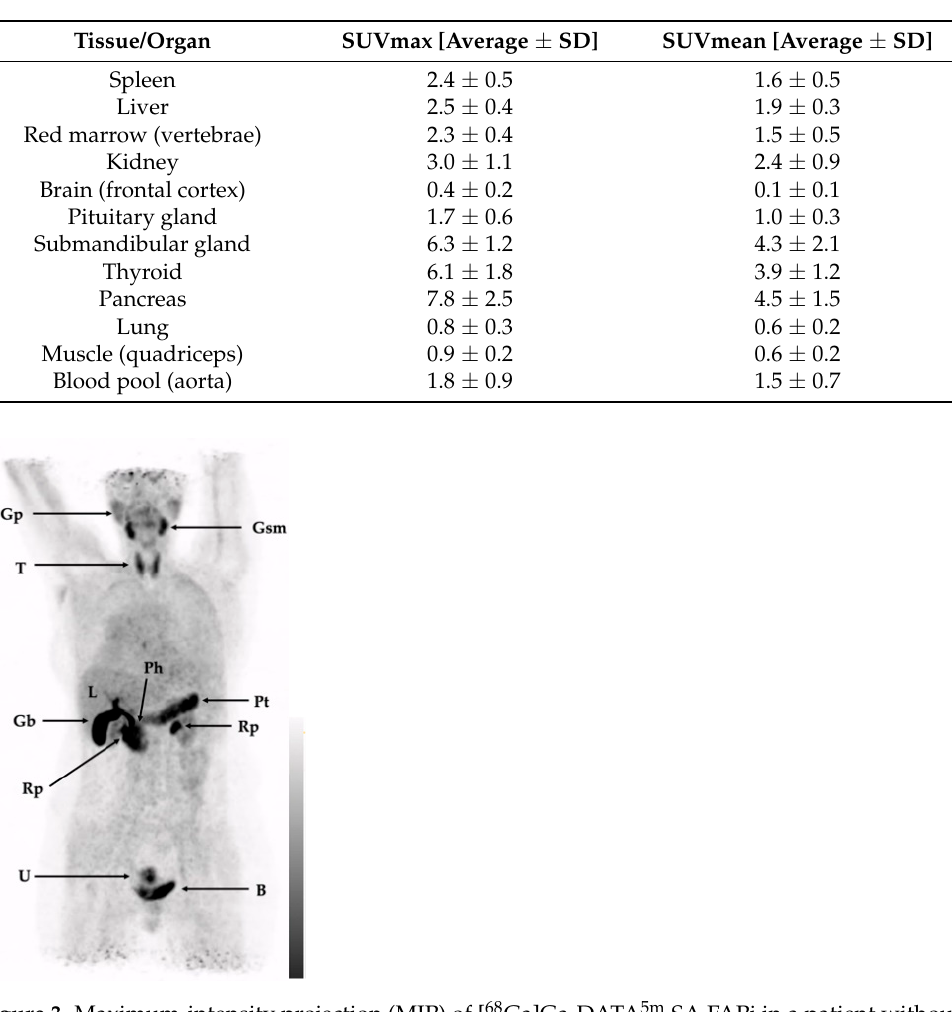
Table 1. Physiological uptake (SUV max and SUV mean ) of the tracer [average ± SD] in selected organs and tissues.